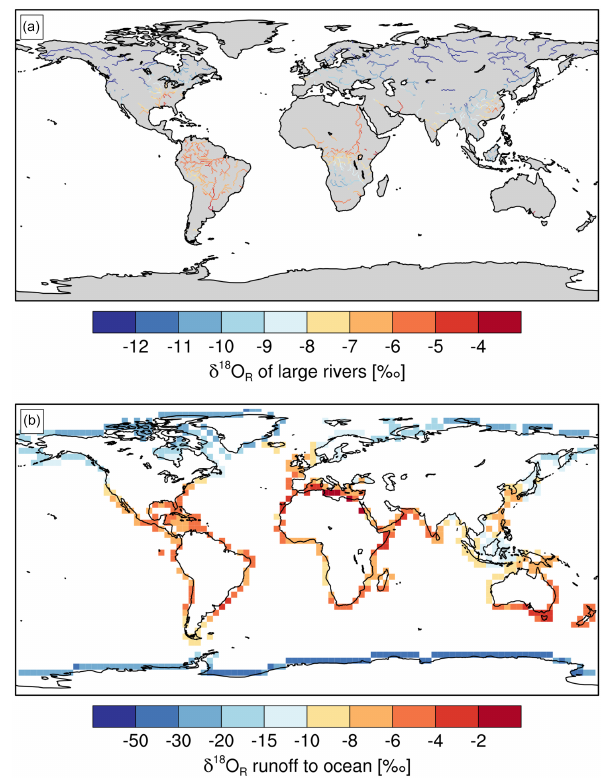
Figure 5. Global distribution of the simulated annual mean δ 18 O R signal in (a) large rivers and (b) surface water runoff from coastal grid points into the oceans, as simulated by the hydrological dis- charge model (HD model) within the ECHAM5/MPI-OM